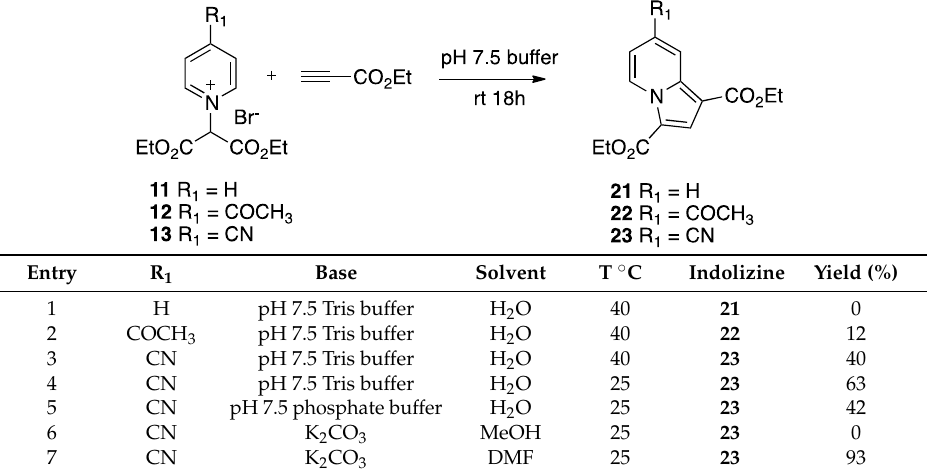
Table 4. Formation of indolizine from diethyl dicarboxylate substituted pyridinium 11 – 13 in pH 7.5 buffer solutions.